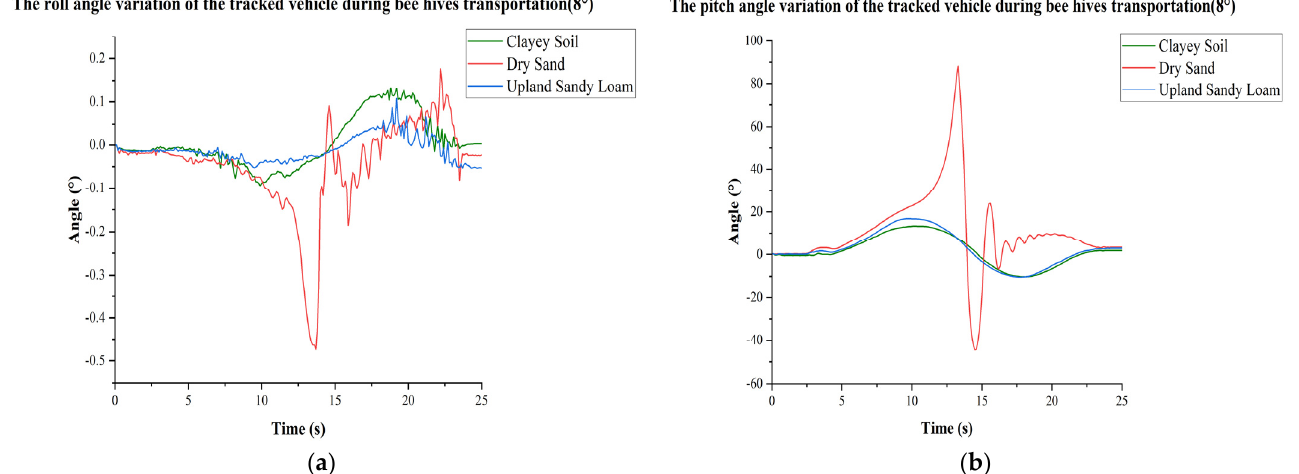
Figure 22. Variation of ( a ) roll values under each pavement condition when the vehicle is fully loaded with beehives (8°) and ( b ) pitch values under for each pavement condition when the vehicle is fully loaded with beehives (8°).